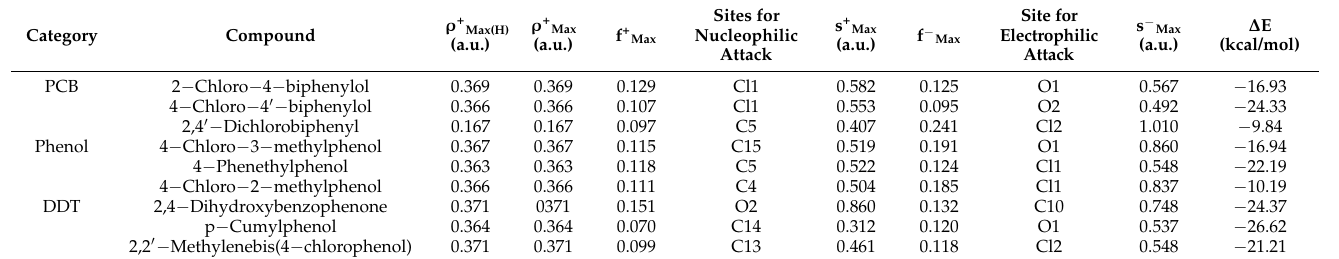
Table 4. The conceptual density functional theory descriptors and binding energies of nine endocrine disrupting chemicals.